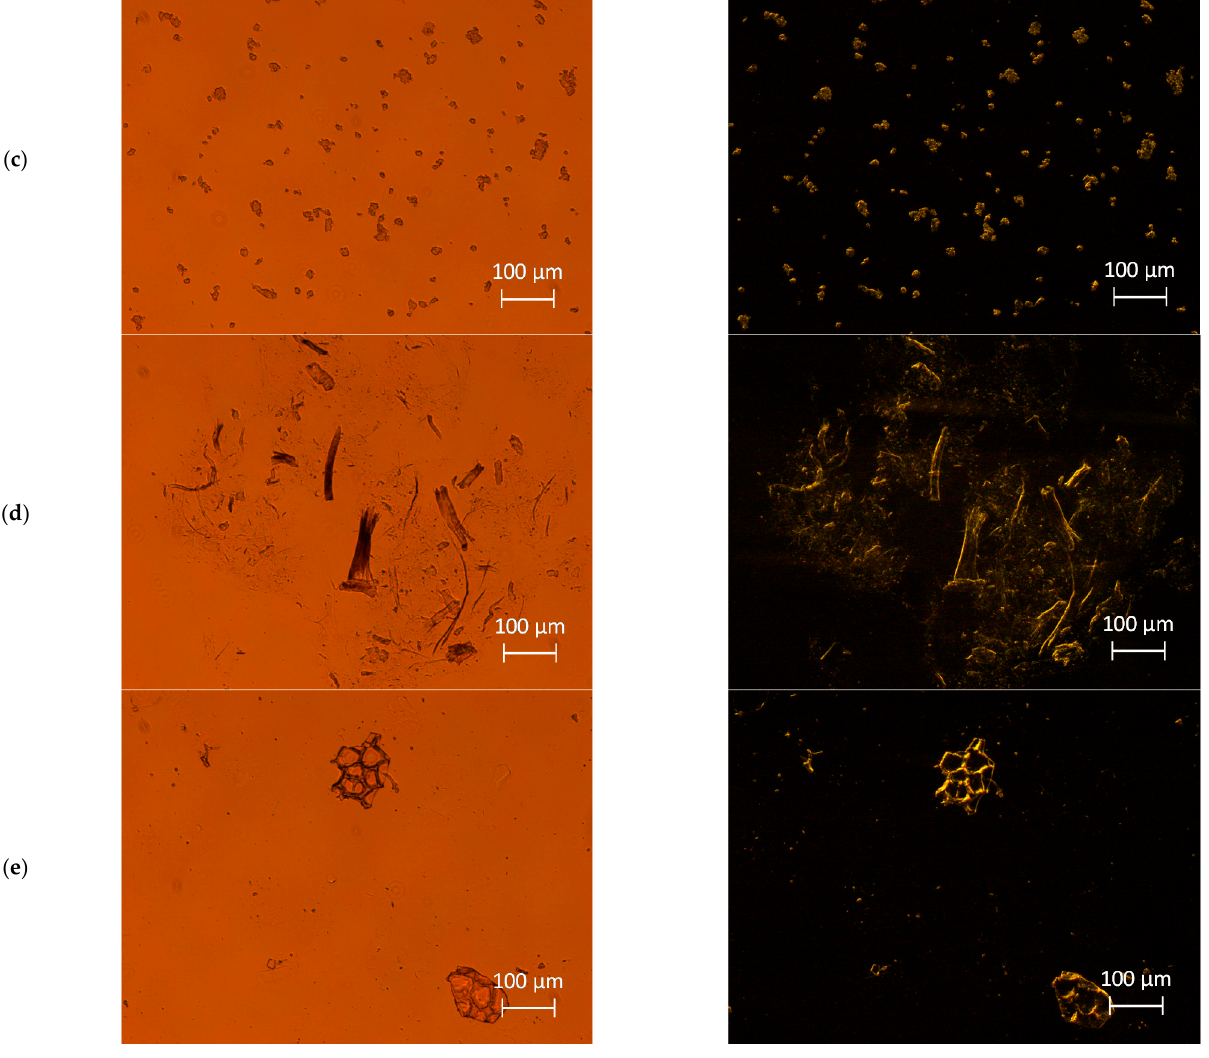
Figure 1. Brightfield (left column) and fluorescence (right column) micrographs of ( a ) untreated cellulose, and cellulose treated by ball milling for ( b ) 30 min ( c ) and 60 min, by ( d ) HPH treatment for 10 min, and ( e ) HPH-treated tomato pomace aqueous suspensions.